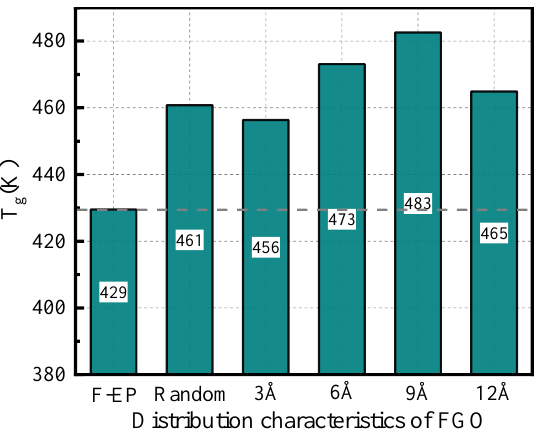
Figure 4. Glass transition temperature of FGO/F-EP composites with different distribution charac-